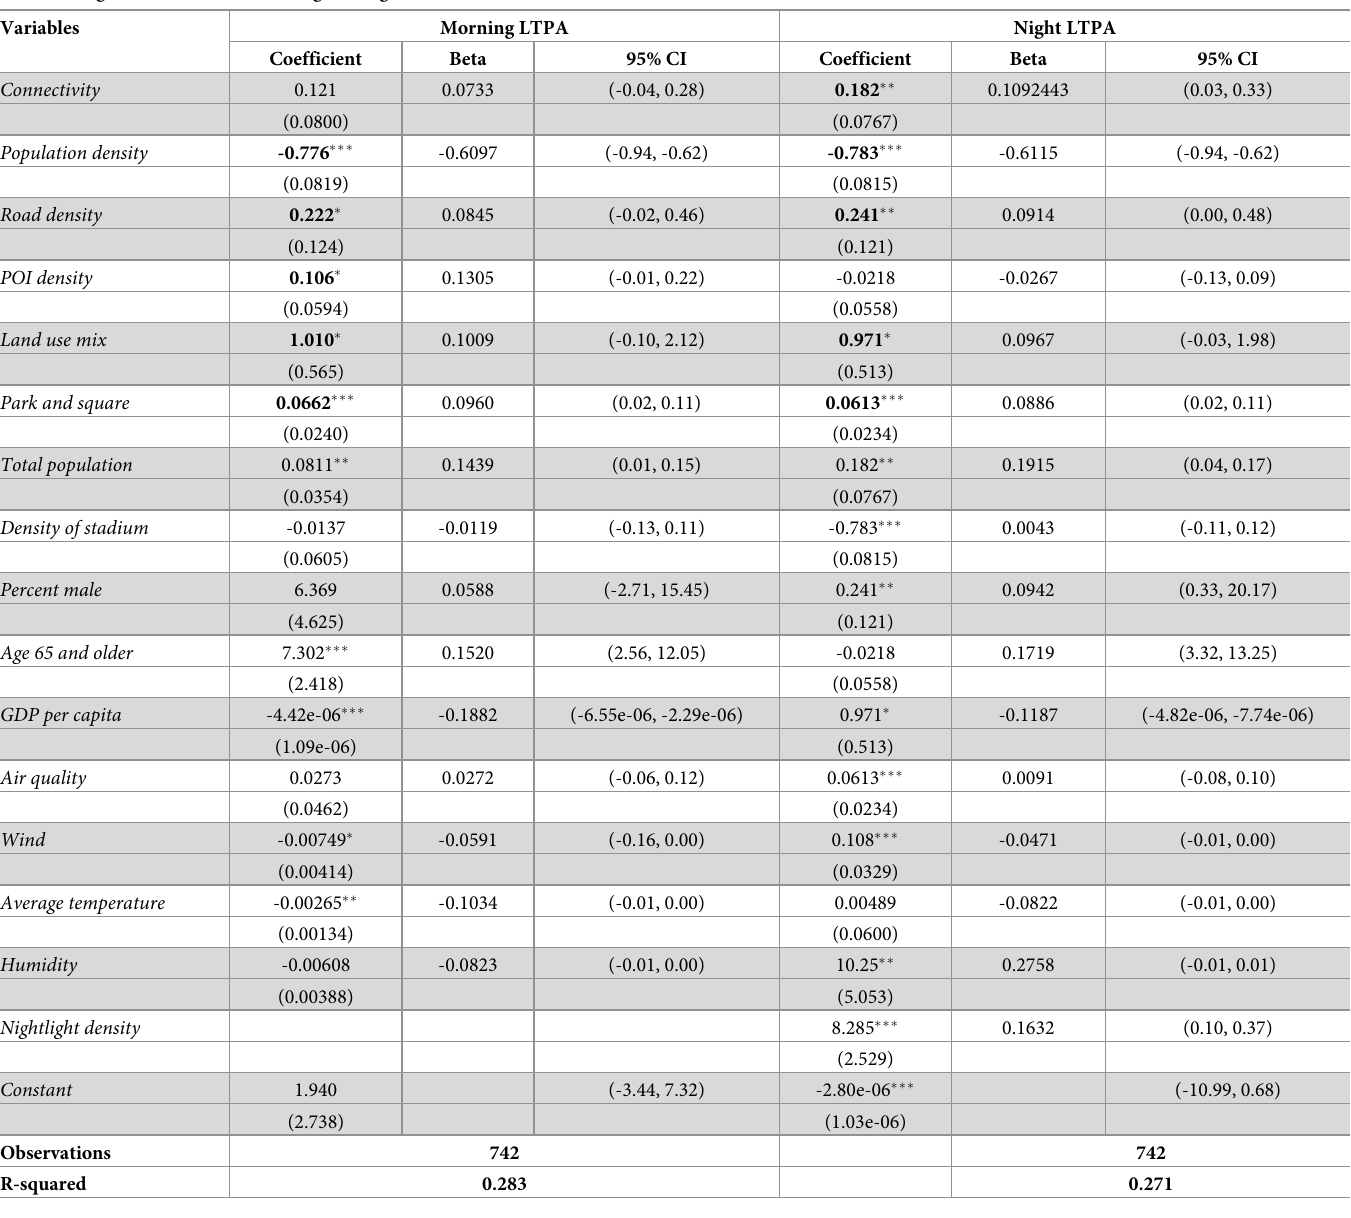
Table 5. Regression results of morning and night LTPA and built